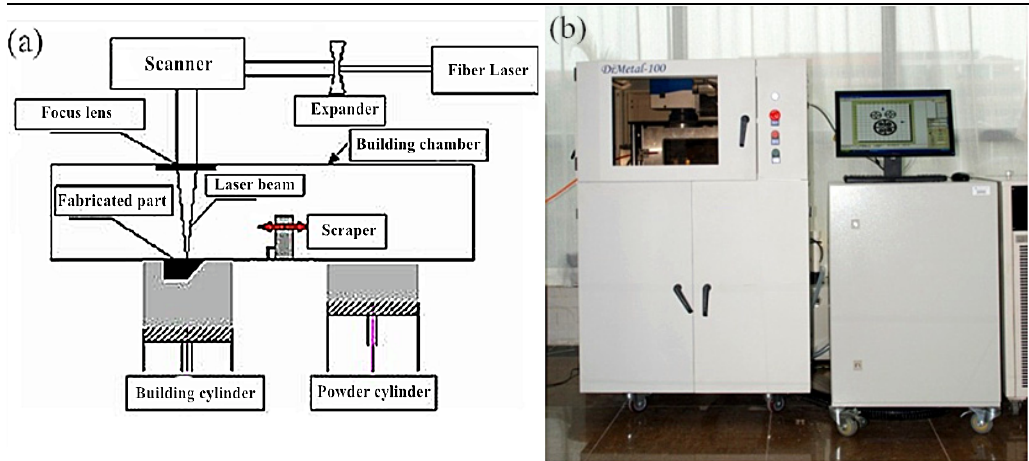
Figure 2. SLM manufacturing principle and apparatus: ( a ) The SLM manufacturing principle; ( b ) SLM equipment Dimetal-100.